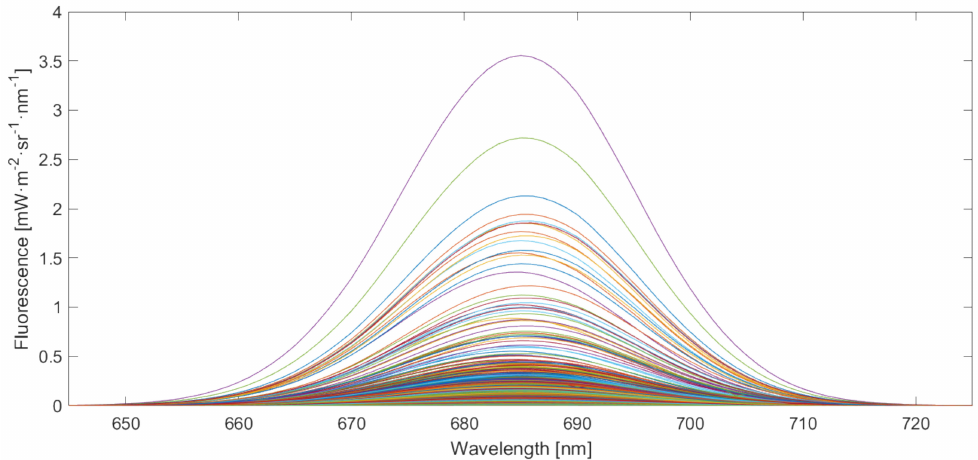
Figure 3. Obtained SICF from the simulated